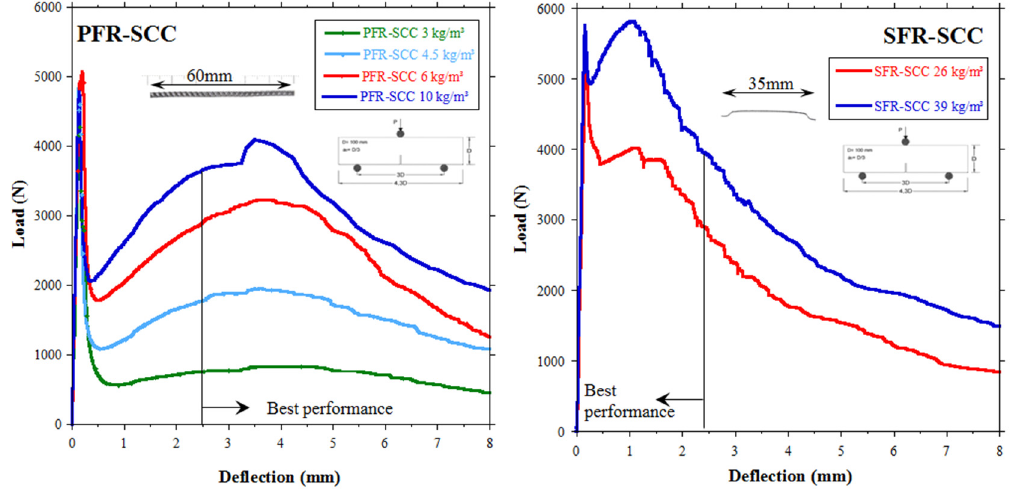
Figure 11. Fracture results using the same mix proportioning of SCC: ( a ) PFR-SCC; ( b ) SFR-SCC.